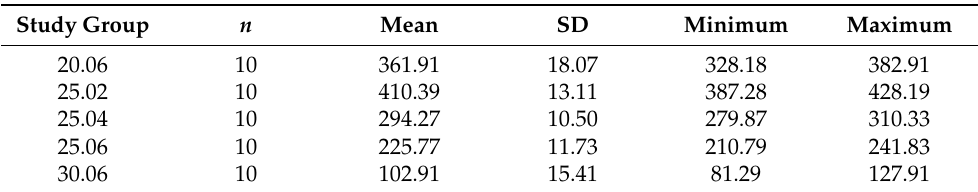
Table 1. Descriptive statistics of the time to failure in relation to the apical diameter and taper study groups.